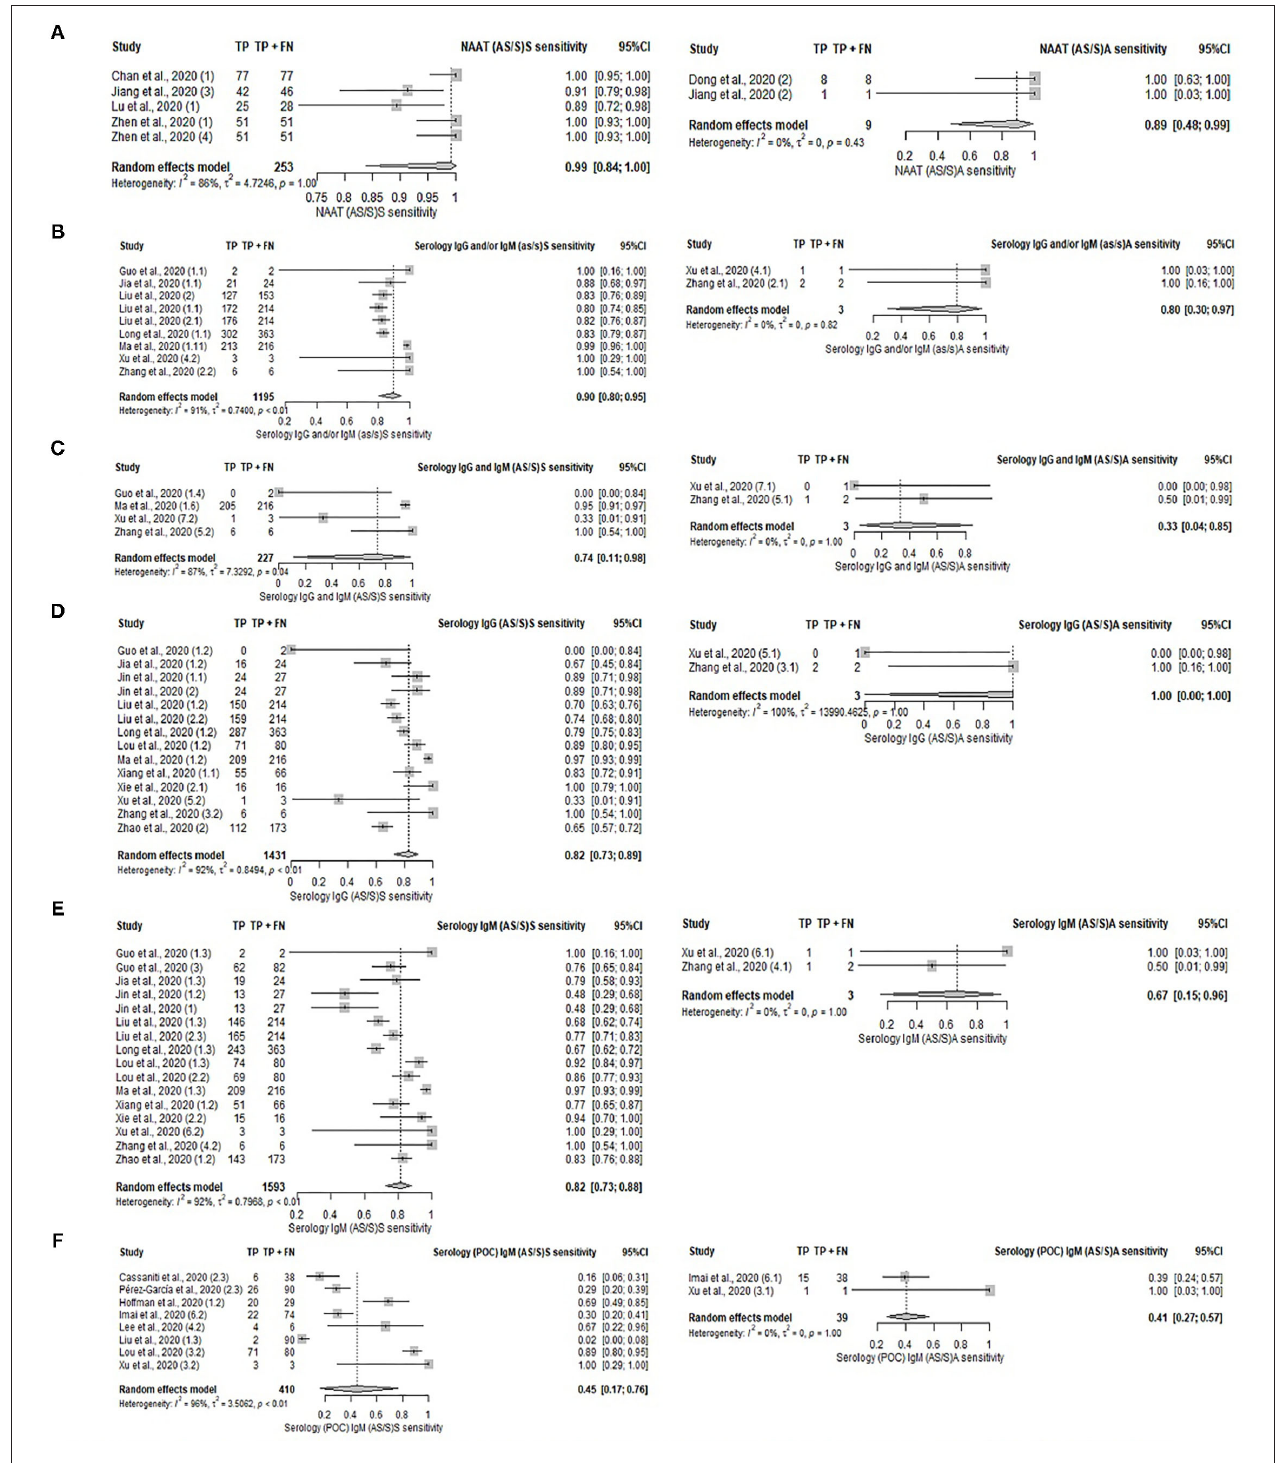
FIGURE 4 | Forest plot on diagnostic test accuracy between symptomatic (left) and asymptomatic (right) patients. (A) NAAT, (B) serology IgG and/or IgM, (C) serology IgG and IgM, (D) serology IgG, (E) serology IgM, and (F) serology IgM (POC).